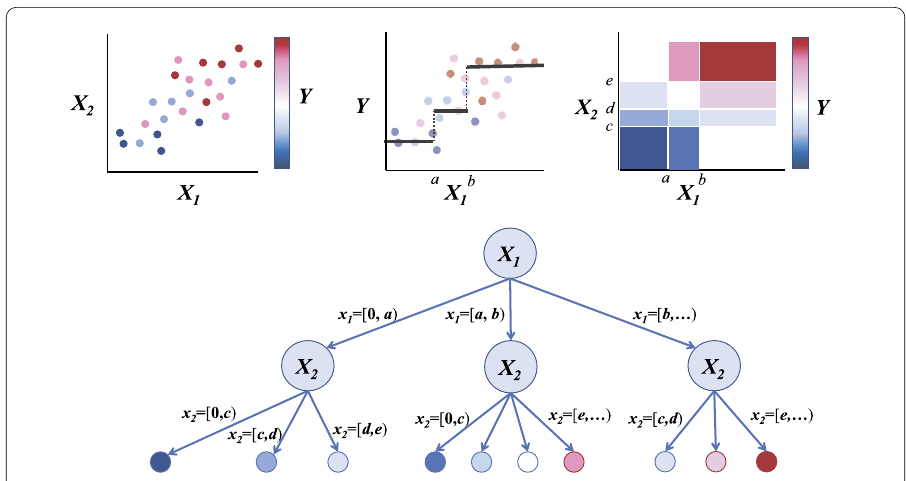
Figure 1 Illustration of S3D learning a model of data. S3D bins the values of each feature (left panel) to select one that explains the largest variation of the outcome Y (middle panel). Next, it bins each unselected feature to identify one that explains the largest amount of the remaining variation. The aerial view of the partition of the important feature space (right panel) represents a visualization of the data, which is also represented by a tree (bottom panel). S3D continues partition the space using features not previously selected, until there is no appreciable variation left to